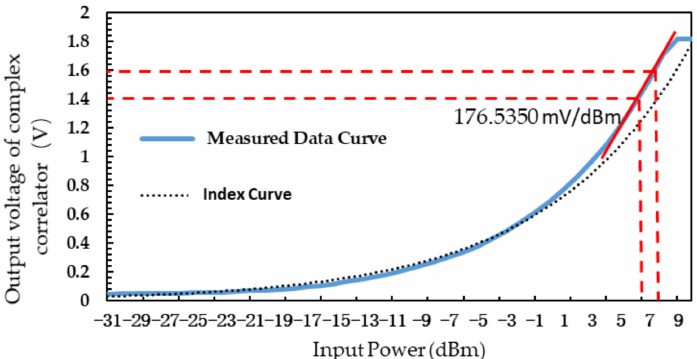
Figure 8. Relationship between input power and output voltage of interferometric complex